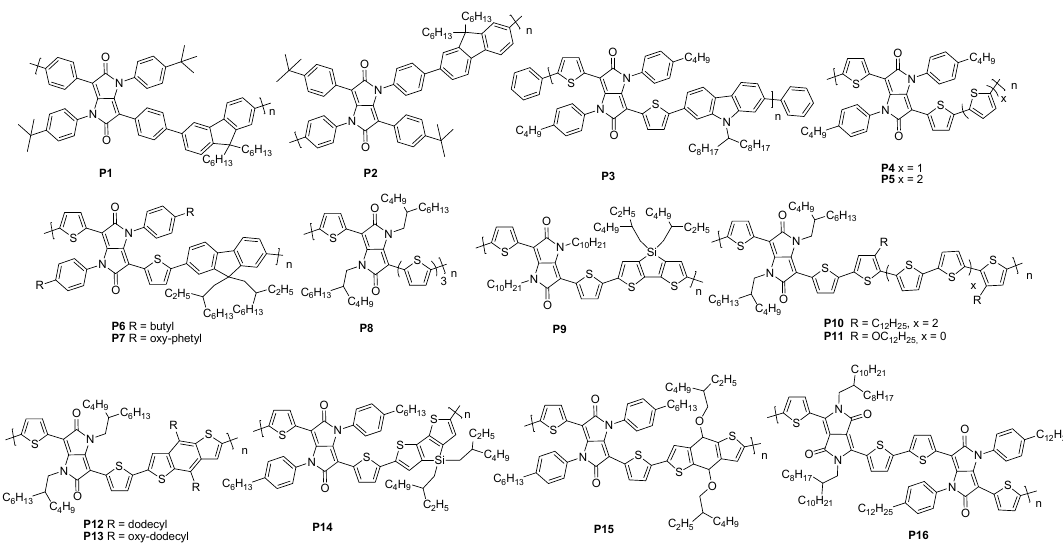
Figure 5. Chemical structure of polymers based on isoDPP.